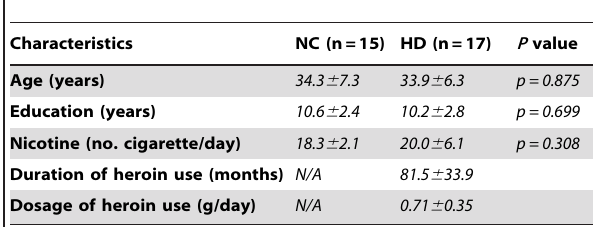
Table 1. Demographic information of HD and